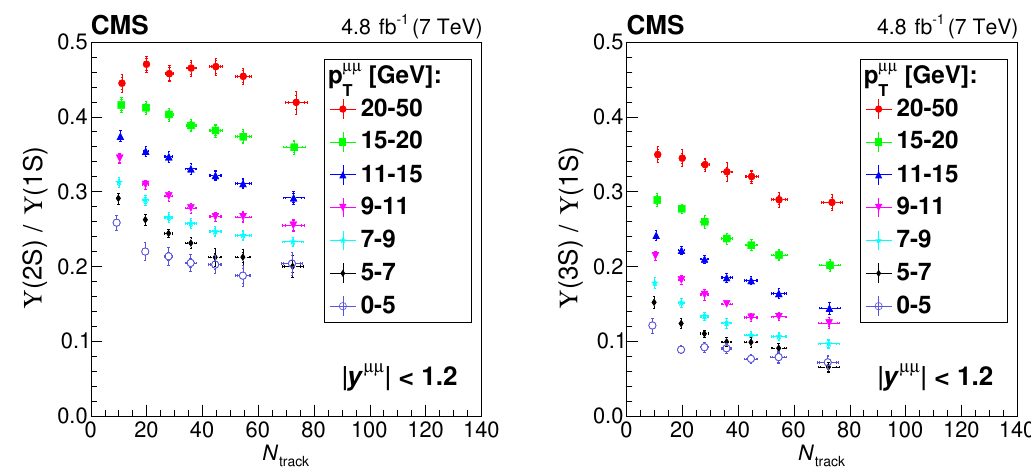
Figure 4 . The ratios (cid:7) (2S) = (cid:7) (1S) (left) and (cid:7) (3S) = (cid:7) (1S) (right) as a function of N di(cid:11)erent p (cid:22)(cid:22) intervals. The interval 0{5 GeV corresponds to an integrated luminosity of 0.3 fb (cid:0) 1 , T the interval 5{7 GeV to 1.9 fb (cid:0) 1 , and the rest to the full integrated luminosity of 4.8 fb (cid:0) 1 . The outer vertical bars represent the combined statistical and systematic uncertainties in the ratios, while the horizontal bars give the uncertainty in the statistical uncertainty, both in the ratio and in